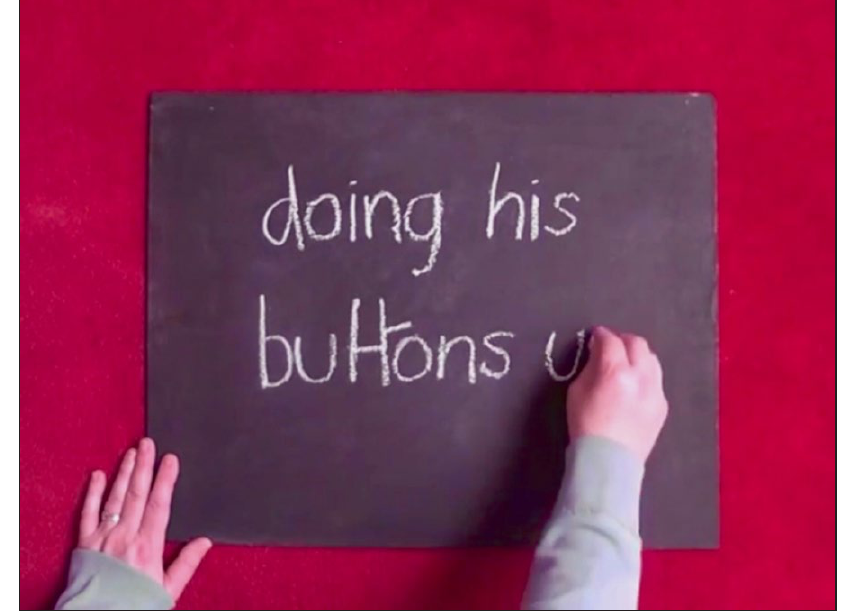
Figure 1: 50 things my son doesn’t need me for